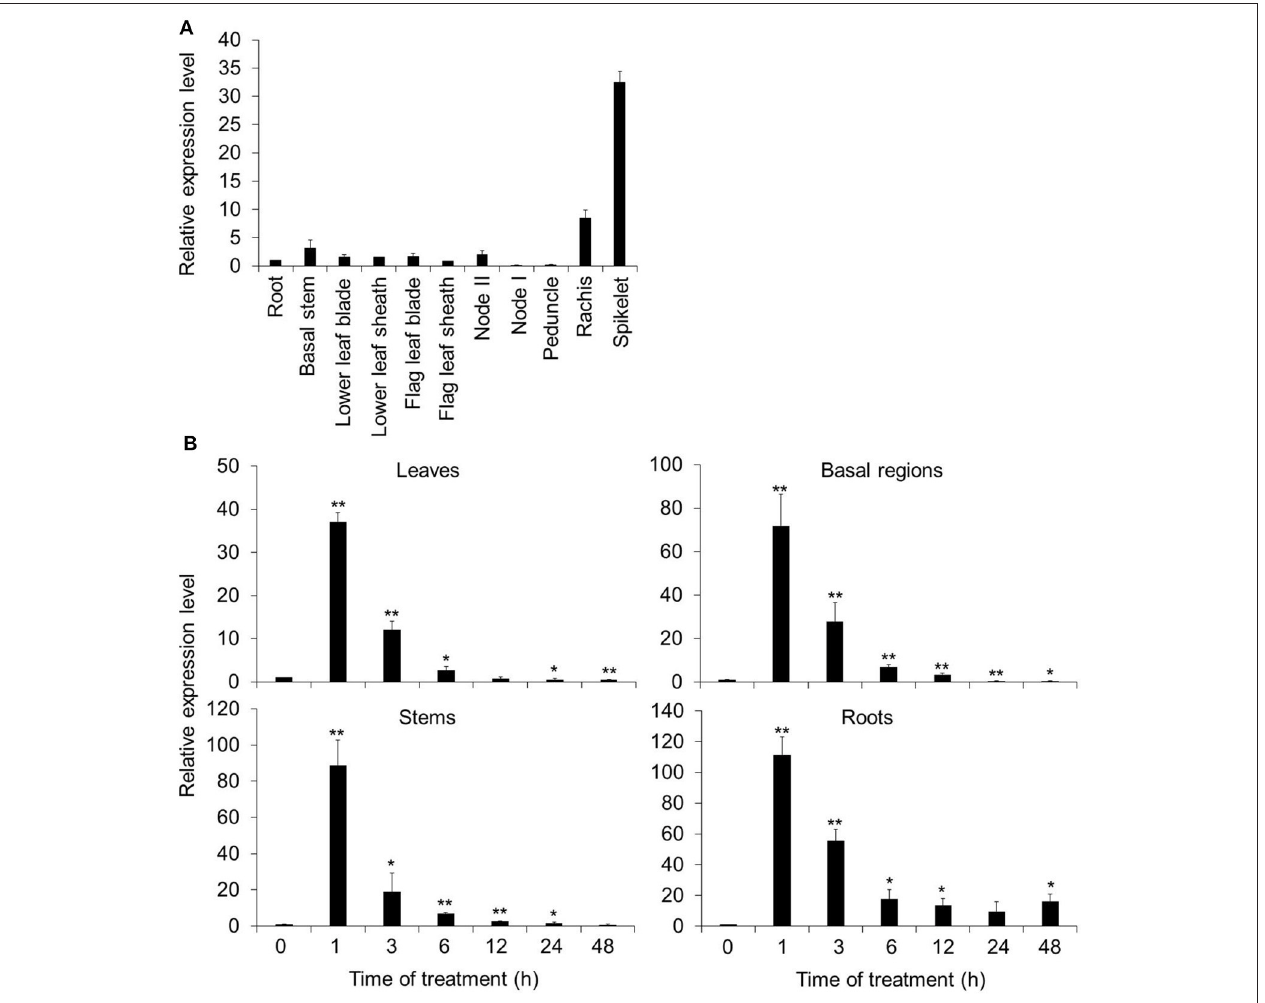
FIGURE 1 | Spatial and temporal expression patterns of OsARM1 . (A) Distribution of OsARM1 transcript in different organs. Total RNA was extracted from various samples (roots, basal stems, lower leaf blades, lower leaf sheaths, flag leaf blades, flag leaf sheaths, node II, node I, peduncles, rachises, and spikelets) harvested from 14-week-old wild-type Nipponbare (NPB). (B) Induction of OsARM1 expression by As(III) treatment. Total RNA was isolated from leaves, stems, basal regions, and roots of 2-week-old NPB treated with 50 µ M As(III). The samples were harvested at 0, 1, 3, 6, 12, 24, and 48h after treatment. The experiments were repeated three times (biological replicates, each replicate was pooled from 12 individual plants) with similar results, and representative data from one replicate are shown. Data are means ± SD ( n = 3) of three technical replicates. OsACTIN1 was used as a reference gene. Asterisks indicate significant differences from wild type (* P < 0.05, ** P < 0.01 by Student’s t